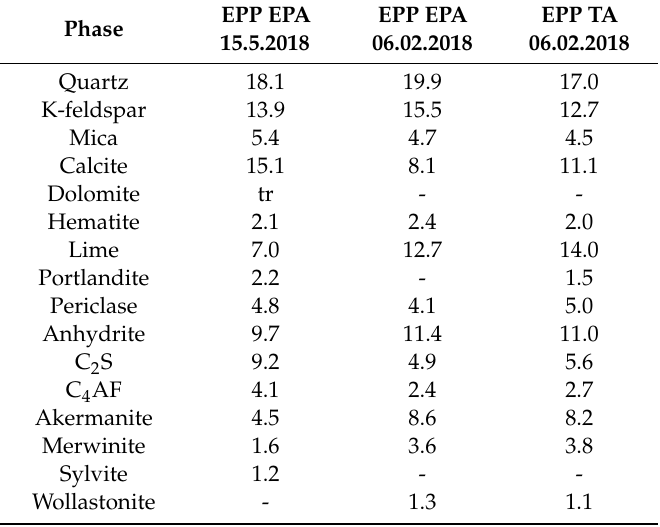
Table 3. Phase composition of EPP (EPA, TA).